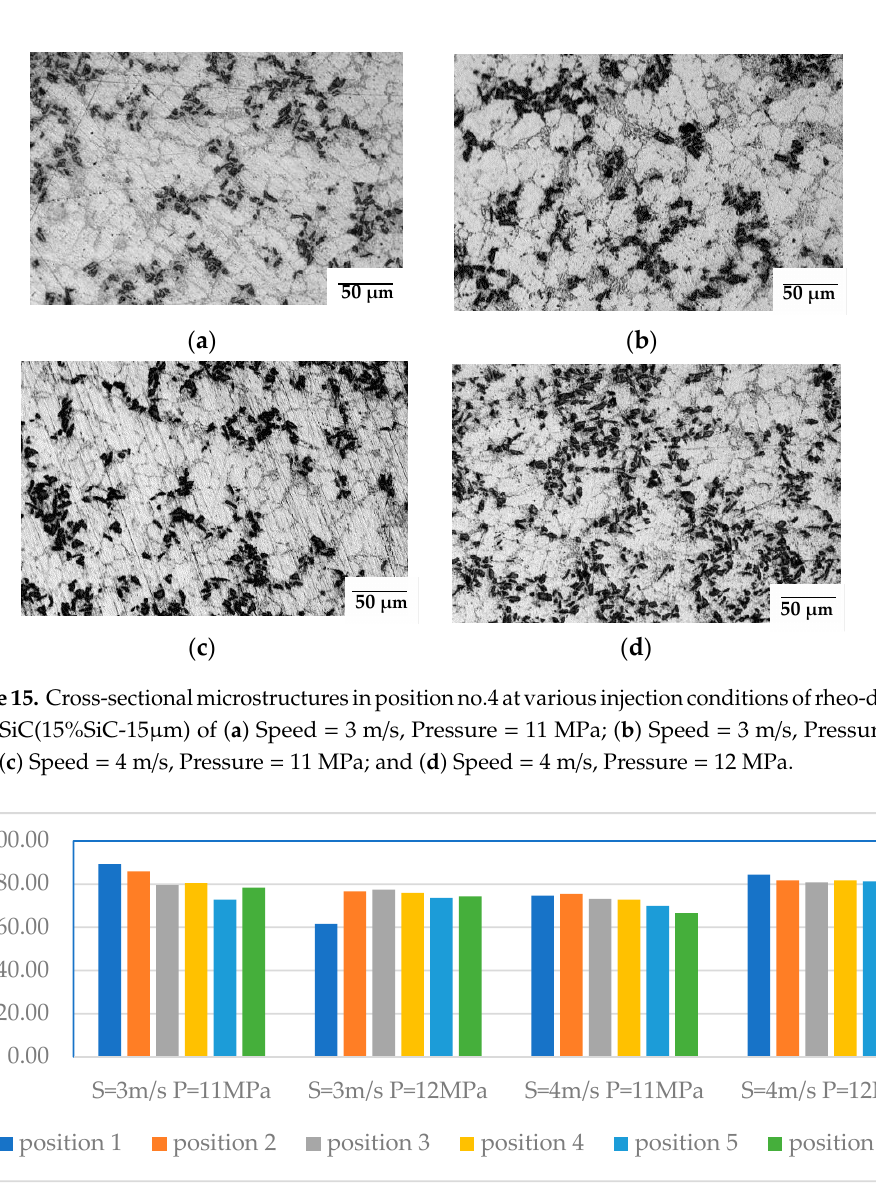
Figure 16. Hardness of rheo-die-cast bars.